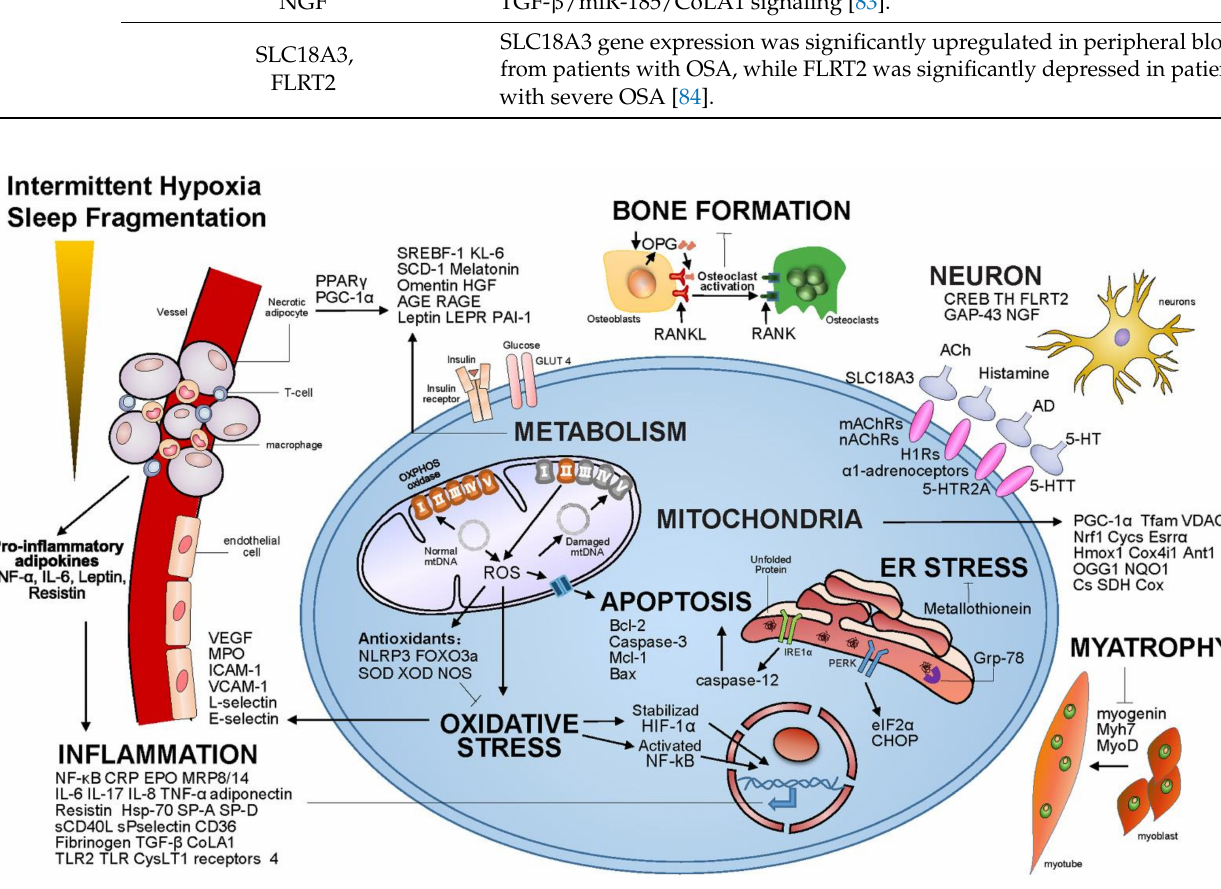
Figure 2. The signaling pathways involved in